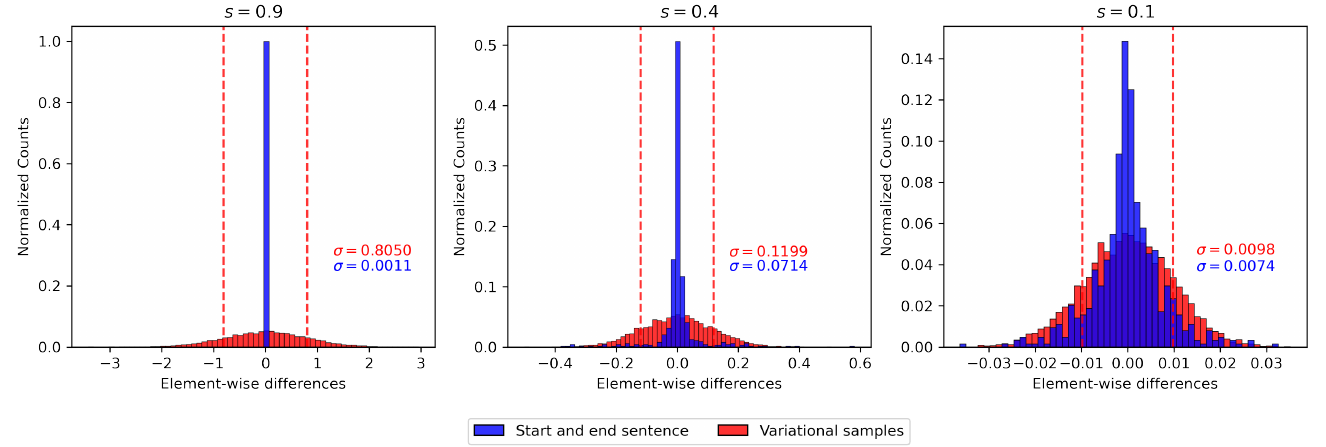
Figure 4. Histogram of the elementwise difference between token vectors from the start and end sentence of the interpolation example in Table 3 (blue) and from the start sentence and 10 random variational samples of this sentence (red) for different scaling values s . σ denotes the value of the standard deviation of the corresponding